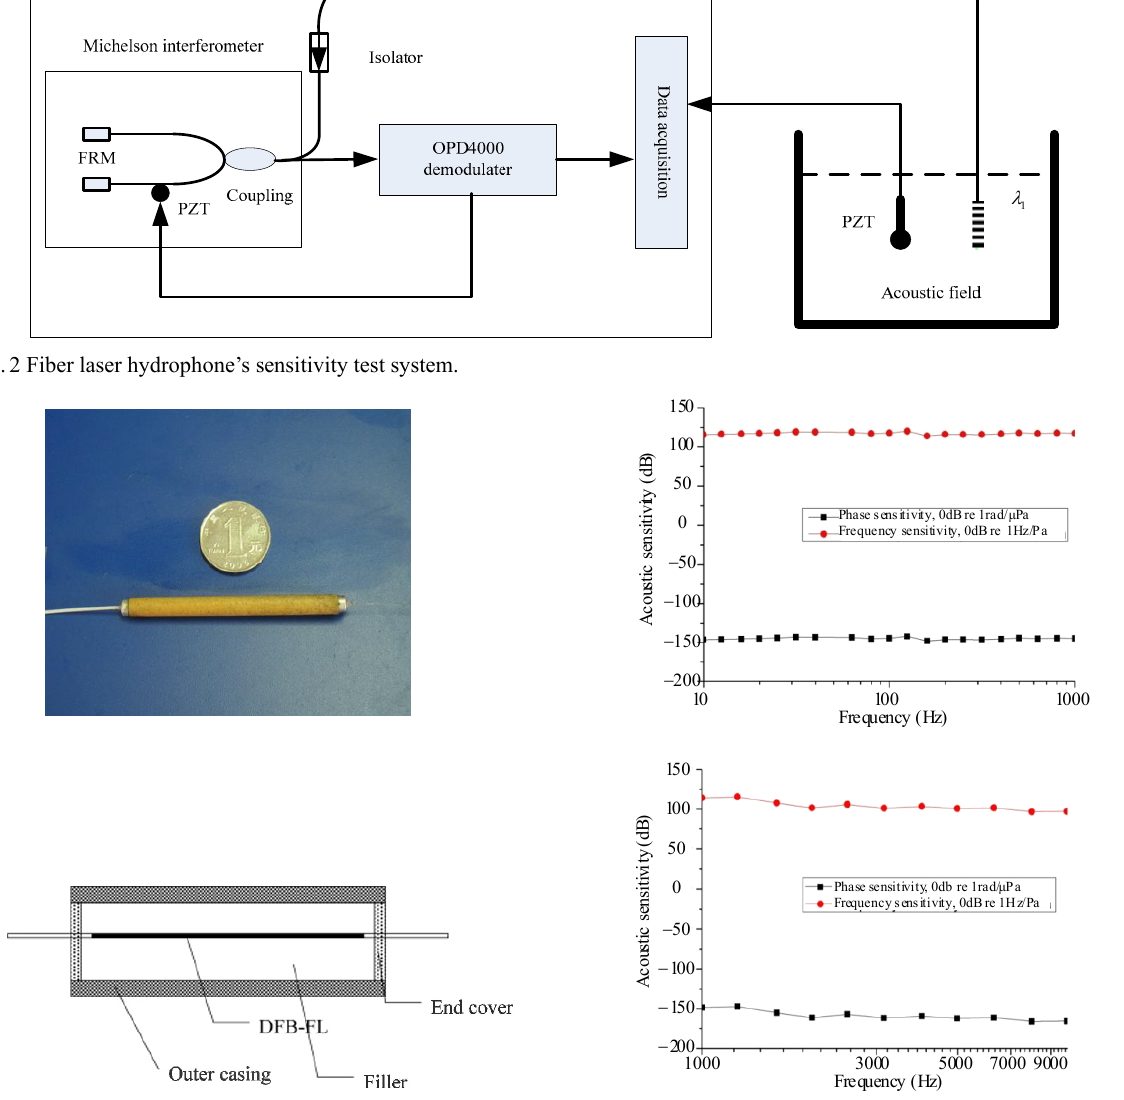
Fig. 3 Fiber laser hydrophone of cylindrical capsulation structure and its sensitivity frequency response